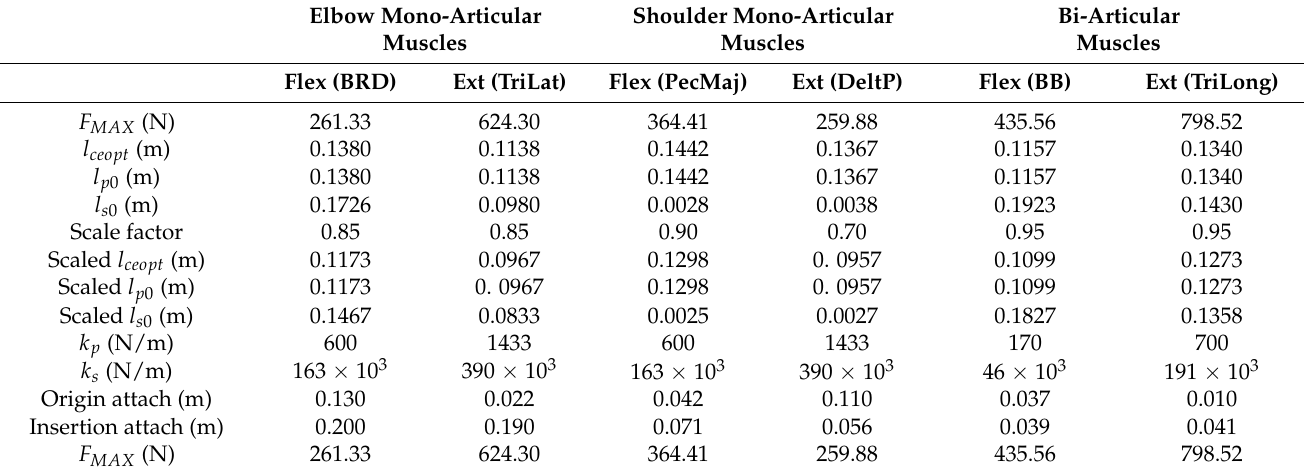
Table A1. Hill muscle parameters obtained from the literature and distance between the joint centers of rotation and the connection between the flexor (Flew) and extensor (Ext) muscles and the bones. The origin attach is intended as the distance between the connection of the origin side of the muscle with the bone, while the insertion attach is intended as the distance between the connection of the insertion side of the muscle with the